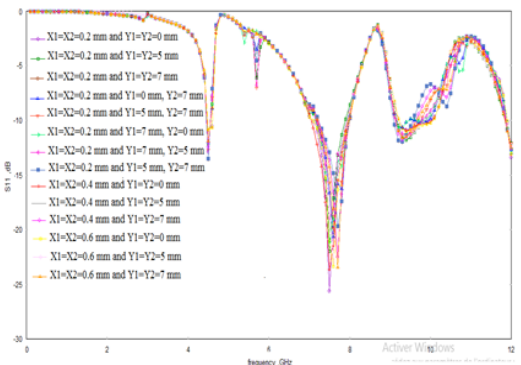
Figure 2. Simulated return loss, S positions.